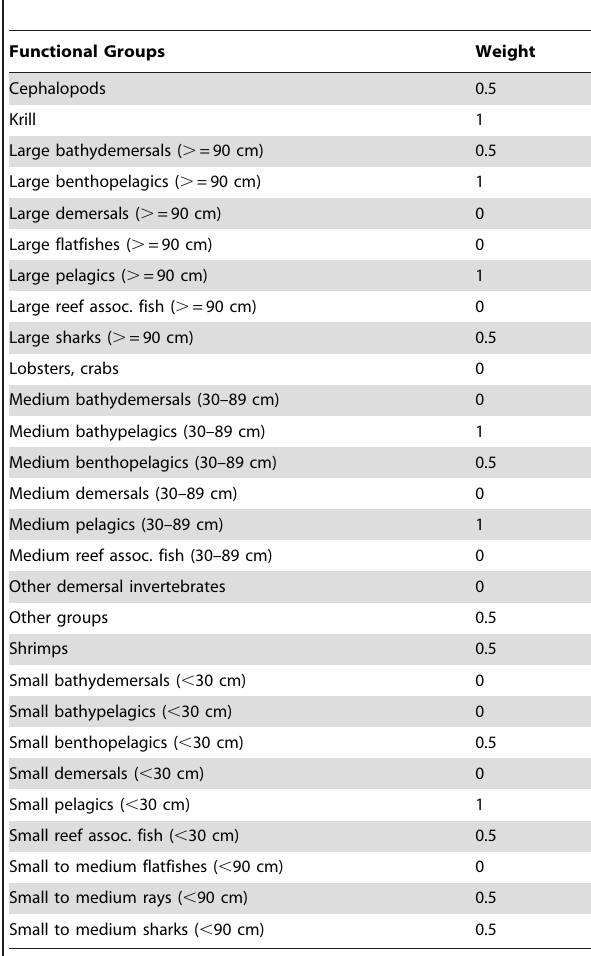
Table 1. Weights (proportion attributed to pelagic feeding) applied to functional groups of fishery